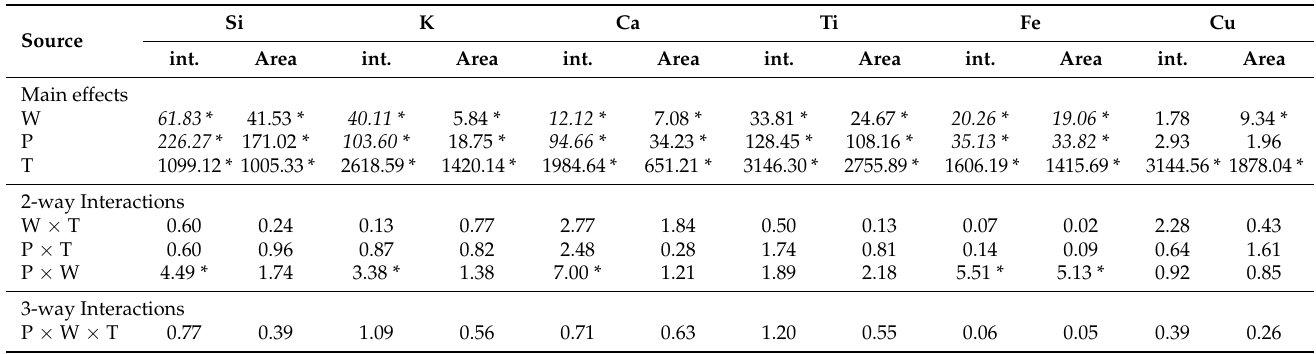
Table 3. Results ( F values) of two-way and three-way ANOVA on the effects of the water content (W), sample preparation (P) and excitation time (T), and their interactions on the peak intensity and peak area of XRF spectrum.